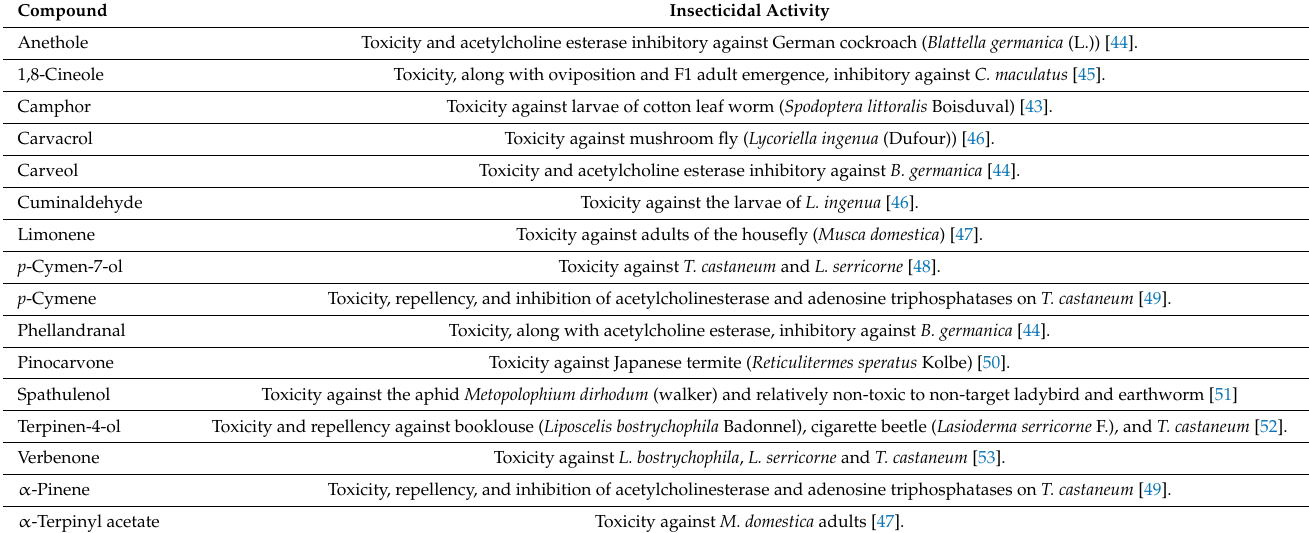
Table 3. Recently reported insecticidal effects of some chemical components existing in E. largiflorens essential